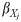
Causal directed acyclic graph used in the data generating model for the simulation study.U represents the set of variables that confound the association between the risk factor X and outcome Y. The genetic effect of Gj on X is βXj, the direct (pleiotropic) effect of Gj on Y is αj, the effect of Gj on U is ϕj, and the causal effect of X on Y is θ.